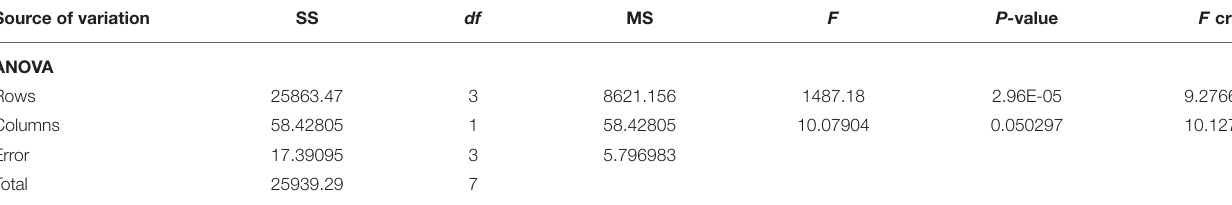
TABLE 9 | Statistical analysis of Kharif season from Table 11 .